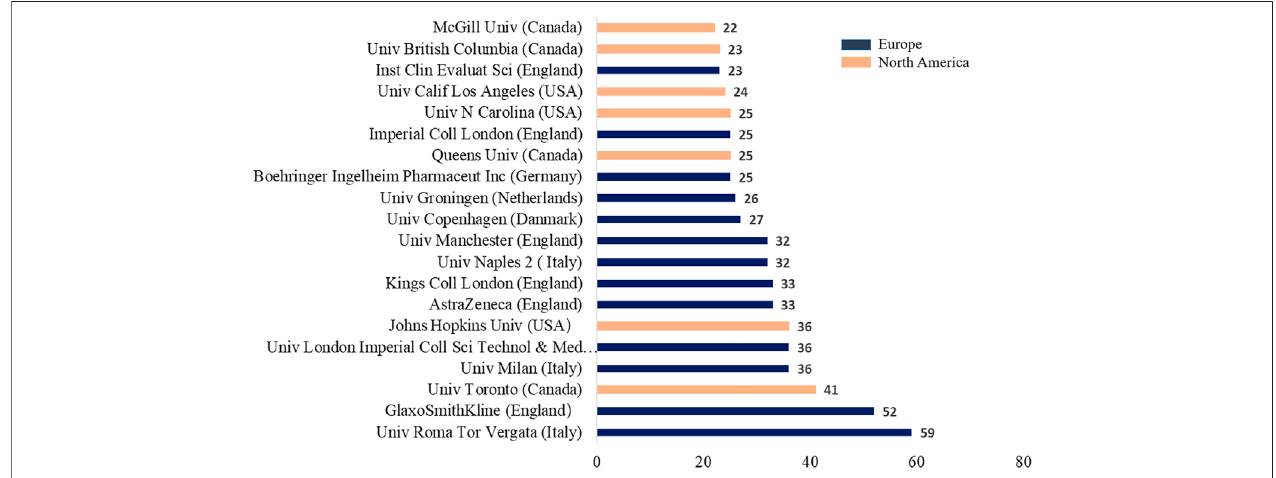
FIGURE 6 | Top 20 institutions that cooperated in publishing COPD drugs-related studies from 1980 to 2021.